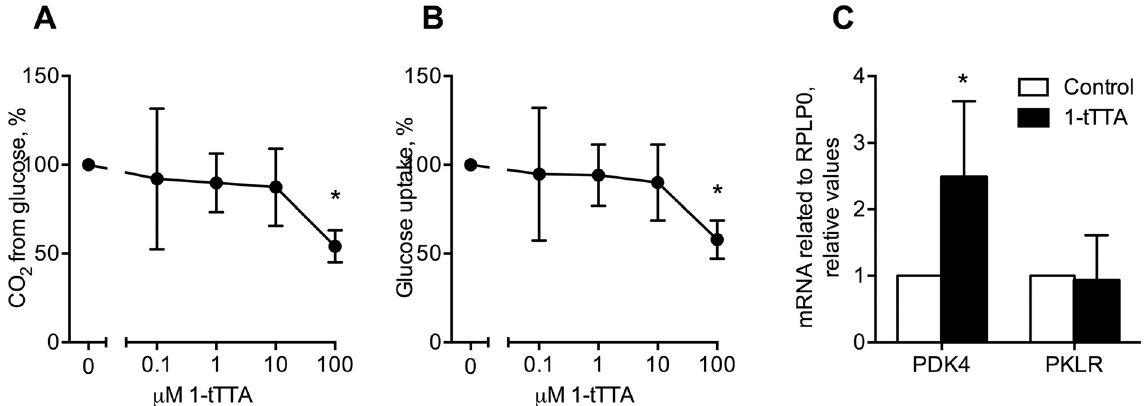
Fig 4. Effects 1-triple TTA (1-tTTA) on glucose metabolism and gene expression in Huh7 cells. Huh7 cells were treated with vehicle (control) or 1-tTTA for 48 h. ( a ) Glucose oxidation. ( b ) glucose uptake. ( c ) mRNA expression of pyruvate dehydrogenase kinase, isoenzyme 4 ( PDK4 ) and pyruvate kinase L/R ( PKLR ) after treatment with 10 μ M 1-tTTA. Gene expression levels were normalized to the house keeping gene RPLP0 and relative values are given. A, B: n = 5, C: n = 4–8. Statistically significant differences between means were determined using Students t-test, � p < 0.05 vs.